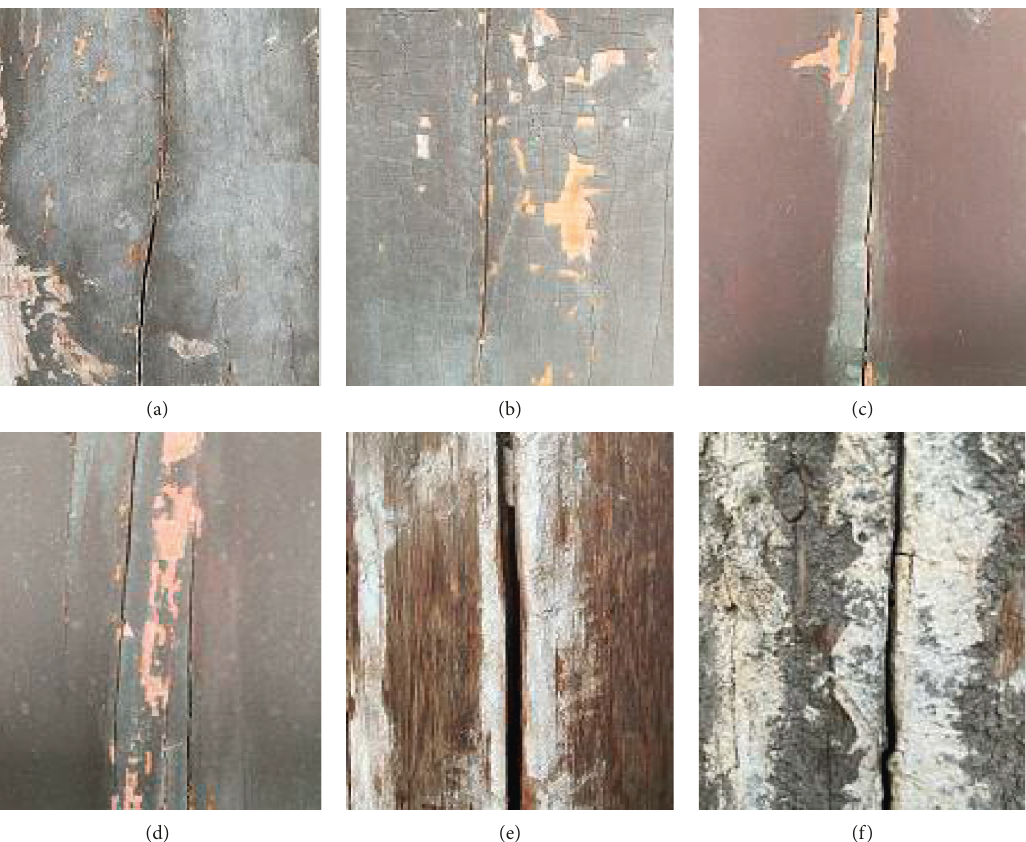
Figure 2: The crack examples in timber structure of ancient architecture. (a) Door crack1 (b) door crack2 (c) window crack1, (d) window crack2 (e) pillar crack1 and (f) pillar